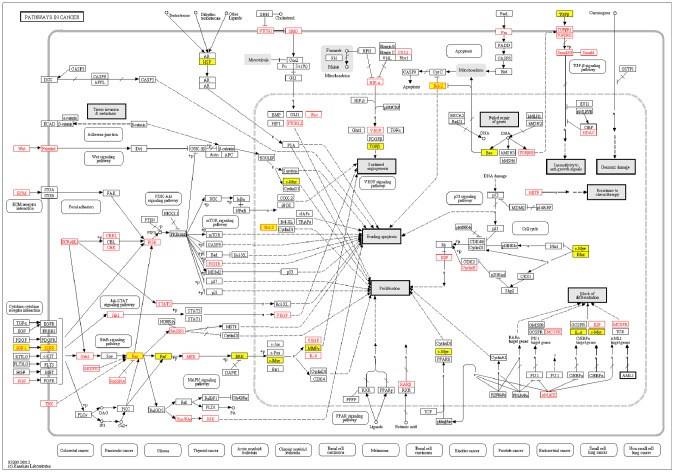
A depiction of the pathways in cancer in KEGG database.Proteins or complexes encoded by MG risk genes are indicated in yellow background, while those in red character represent that their encoding genes are the miRNA-target genes with miRSNPs in their 3′UTR regions. Four important genes (IGF1R, IGF1, RAS, and BCL2) are MG risk genes and meanwhile contain the miRSNPs, and are indicated in red character and yellow background.